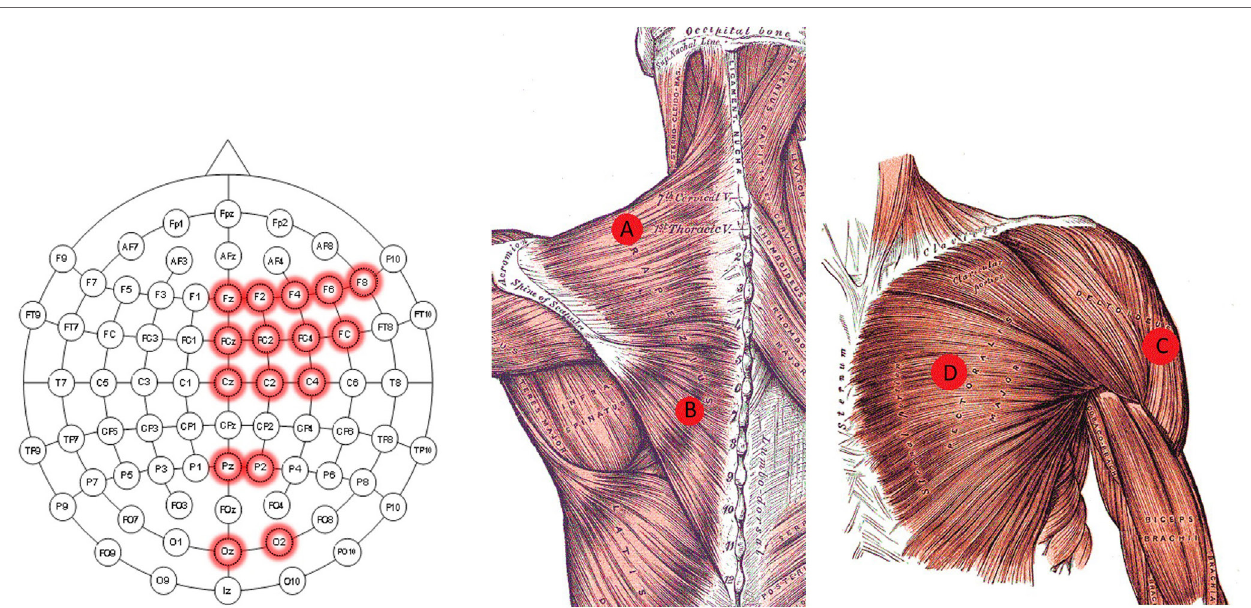
FigUre 2 | electrode location diagram . Those EEG electrodes used for the recordings are highlighted in red in the left image. The approximated location of the EMG electrodes for the trapezius (a,B) is presented in the middle. The approximated location of the EMG electrode for the deltoideus (c) , and pectoralis major (D) are presented in the right image. The middle and right figure are adapted from Gray and Carter